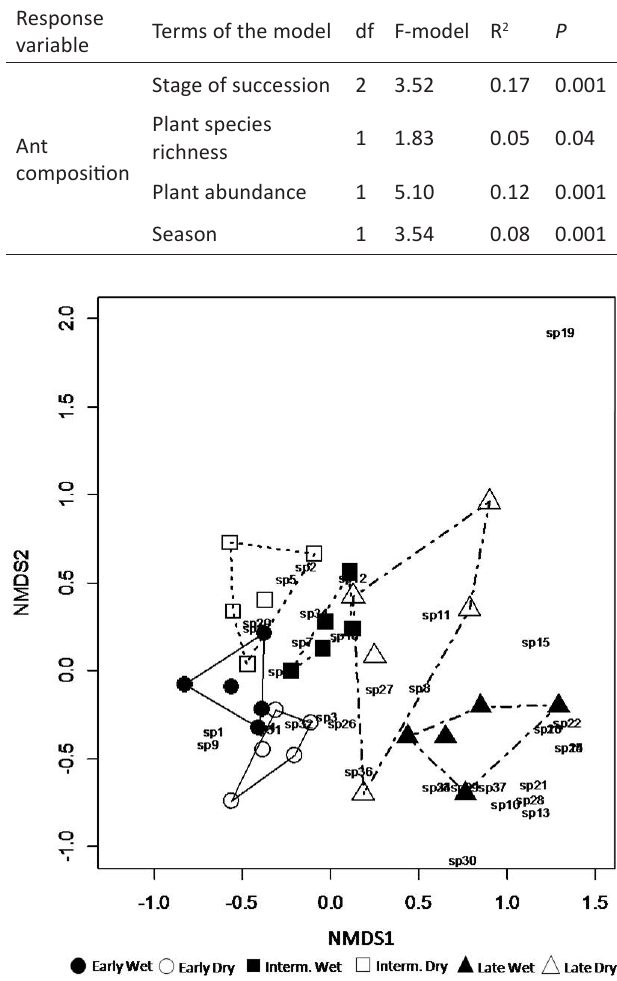
Fig 3 . NMDS ordination of the 37 ant species along three successional gradients (Early, Intermediate and Late) in a Caatinga environment, between dry and wet